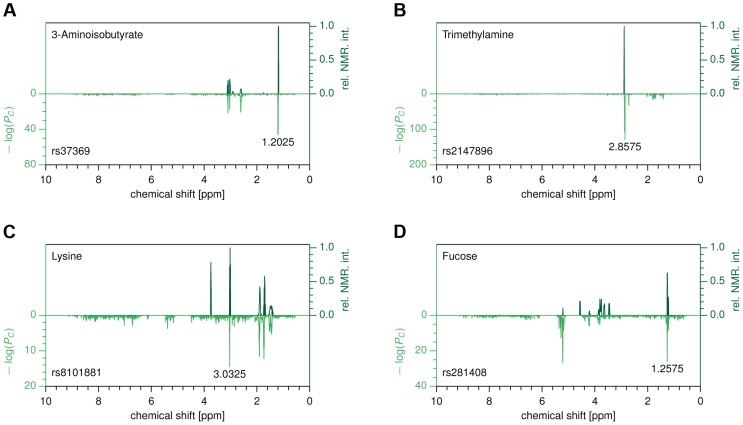
Metabomatching.Each subfigure compares the CoLaus pseudo-spectrum (bottom half) with the NMR spectrum (top half) of the most likely candidate for the associated metabolite. (A) rs37369 vs. 3-aminoisobutyrate. (B) rs2147896 in PYROXD2 vs. trimethylamine (C) rs8101881 in SLC7A9 vs. lysine (D) rs281408 in FUT2 vs. fucose.